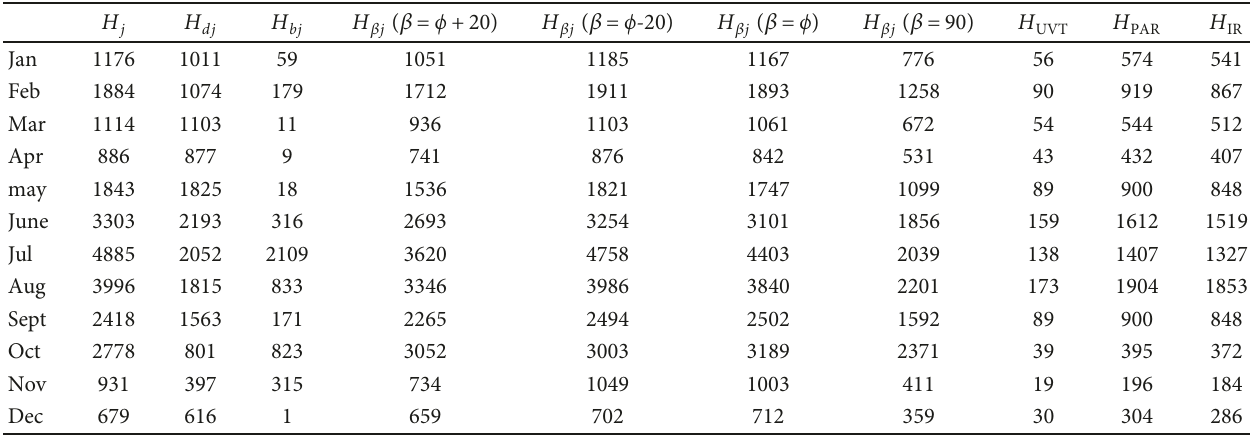
Table 11: Representative year monthly minimum